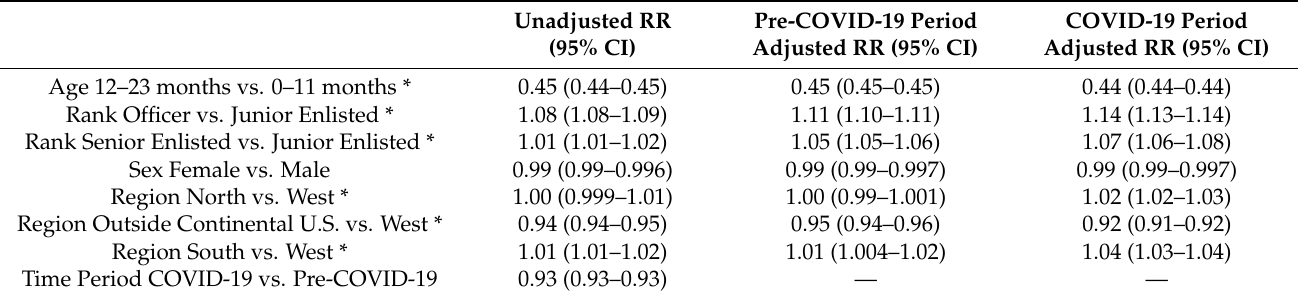
Table 3. Well-Child Visit Rate Ratios